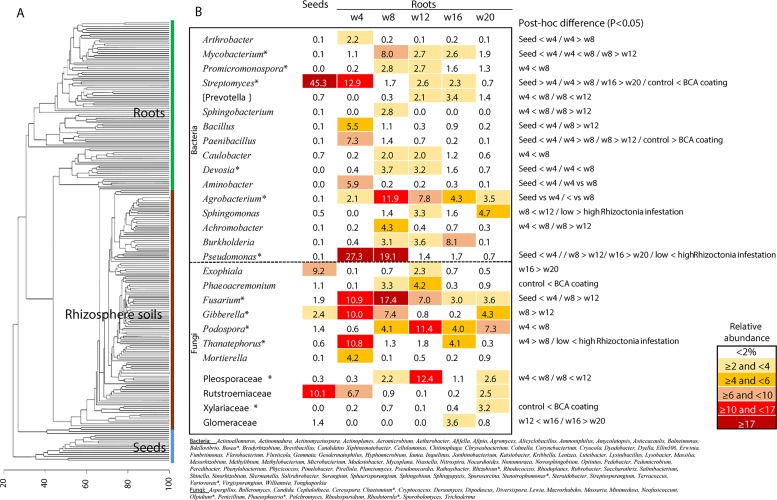
(A) Clustering analysis of all samples included in the study; (B) relative abundance of the core bacteria and fungi found in seeds and roots during the entire study (in the table the taxa with at least 2% in any sampling time; the complete list of core bacteria and fungi classified at genus level is below the table and includes the taxa with low relative abundance—* marks the taxonomic groups with core ASVs found in all sampling time points); the data for control and biocontrol treatments was pooled for these analyses. Details of post hoc plots can be seen in
Supplemental Materials 6, 7, and 10
.